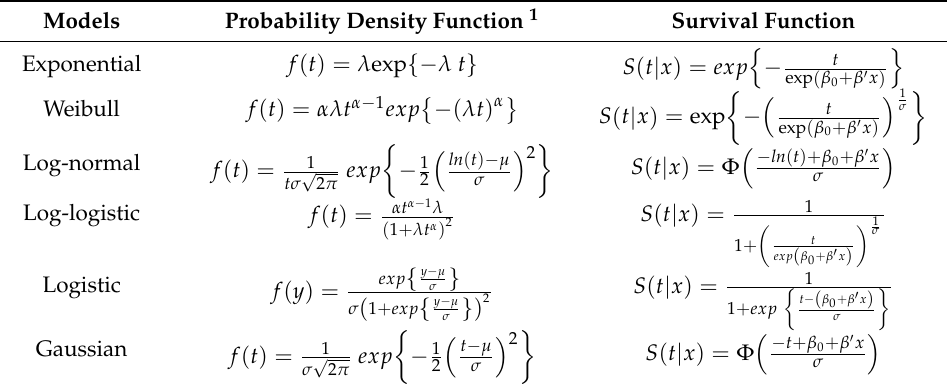
Table 1. The probability density functions and survival functions for the models used in the analysis of Chrysoperla externa exposed to neem-based